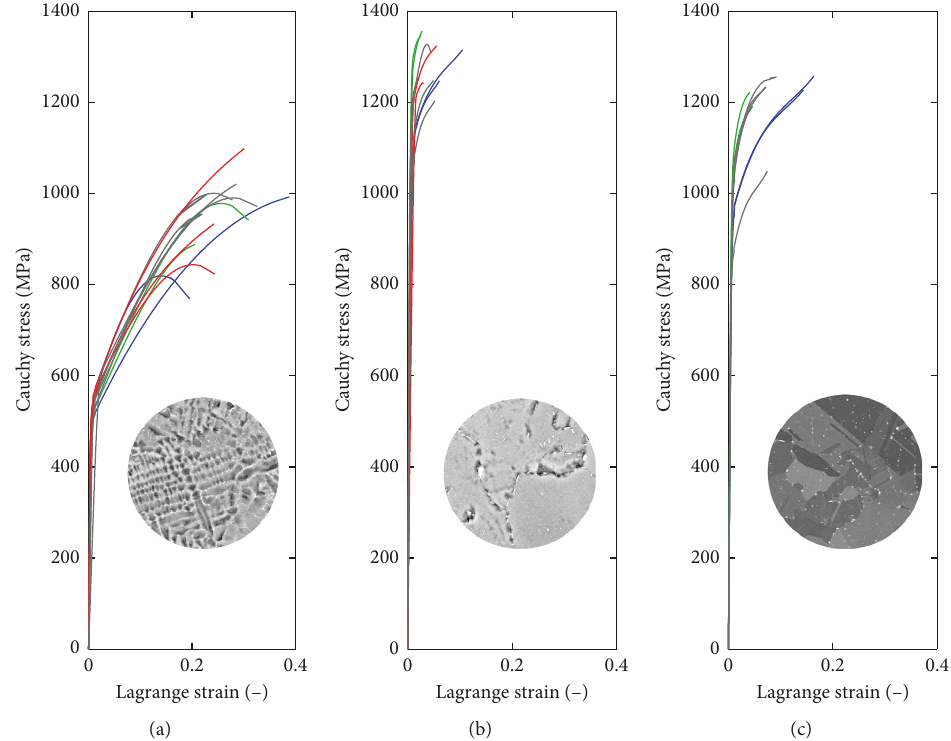
Figure 13: Cauchy stress plotted versus Lagrange strain for (a) S condition, (b) S + A condition, (c) S + H + A condition. Colours are according to Table